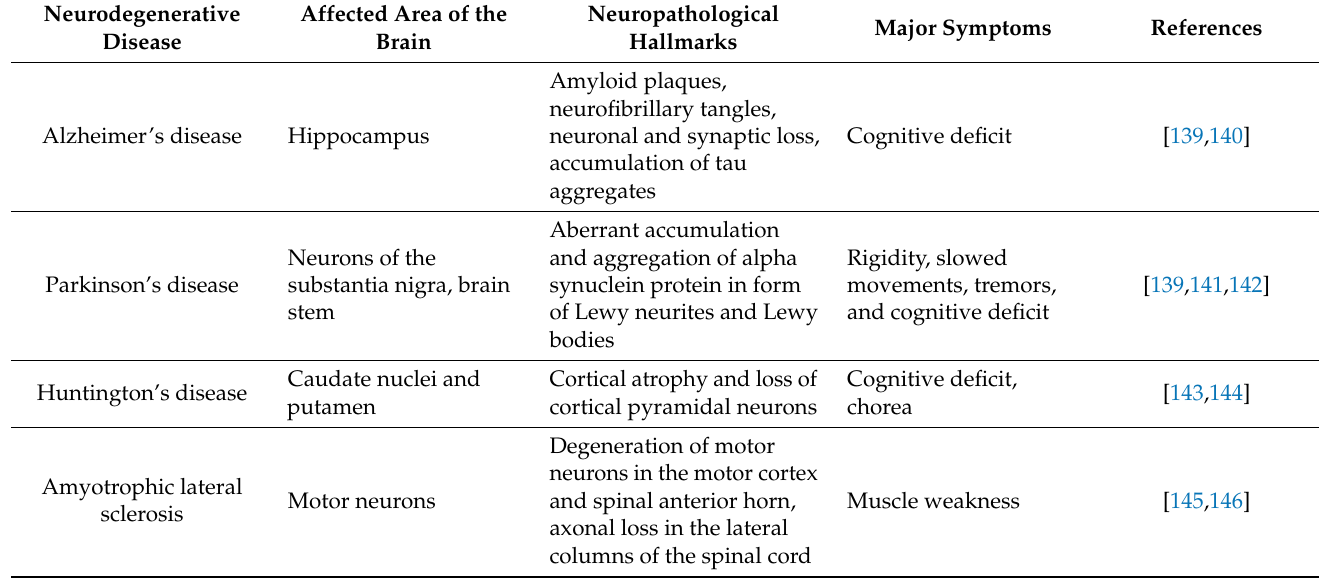
Table 2. Features of neurodegenerative